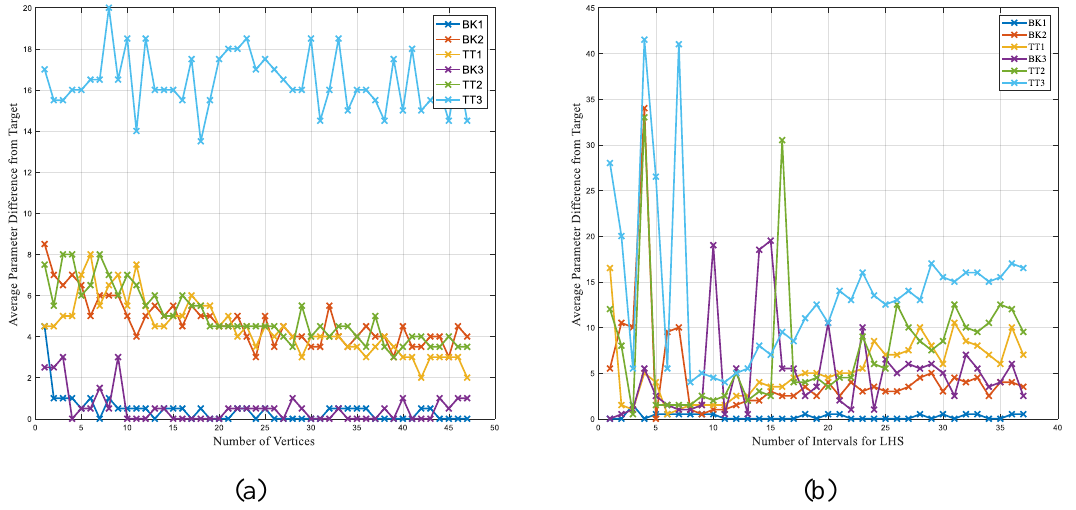
Figure 6. Error for smart search using Nelder – Mead (NM) and Latin Hypercube Sampling (LHS) methods in various vertices and random samples. ( a ) The distance from the target value for various simplexes. ( b ) The distance for the NM optimization using LHS with a various number of intervals to limit the search.